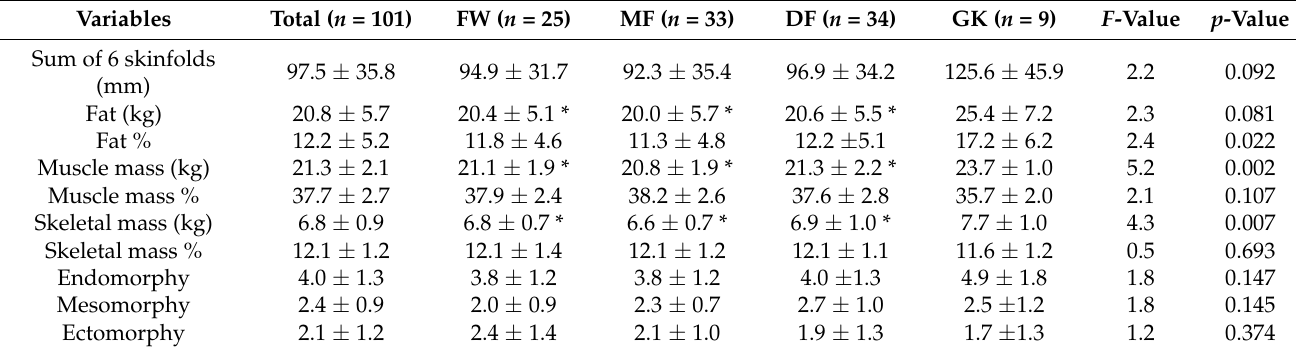
Table 2. Body composition characteristics of sub-elite female football players by positional group (mean ± SD).